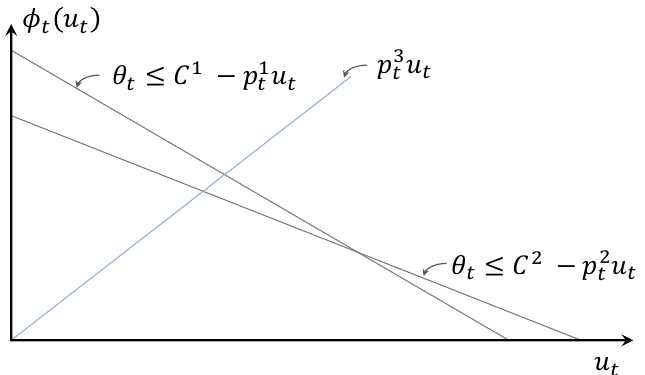
Figure 4. Illustration of the representation of the uncertain objective term price. The EFP function w.r.t. to the auxiliary variable u t is given, and x t is assumed fixed and added to the parameter C . Observe that the cuts represent the potential for future profit, whereas the sampled objective term coefficient p 3 describes the present profit potential. Thus, the model can compute the trade-off between